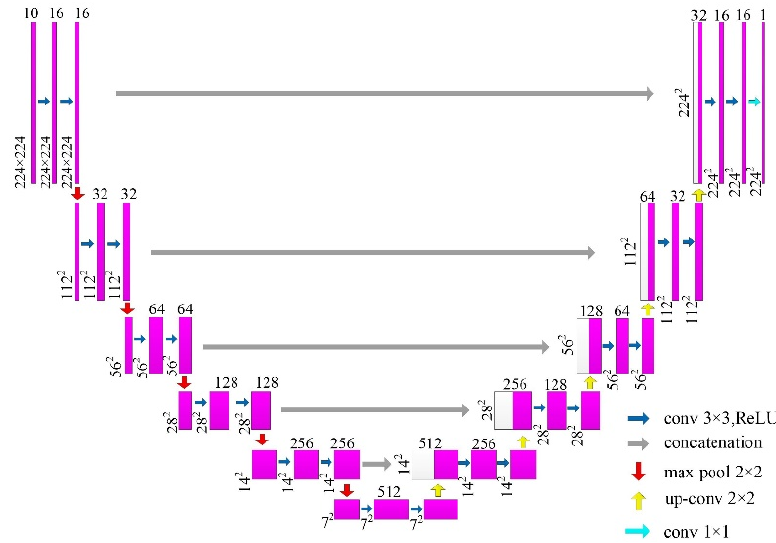
Figure 9. Adapted implementation of the U ‐ Net architecture.